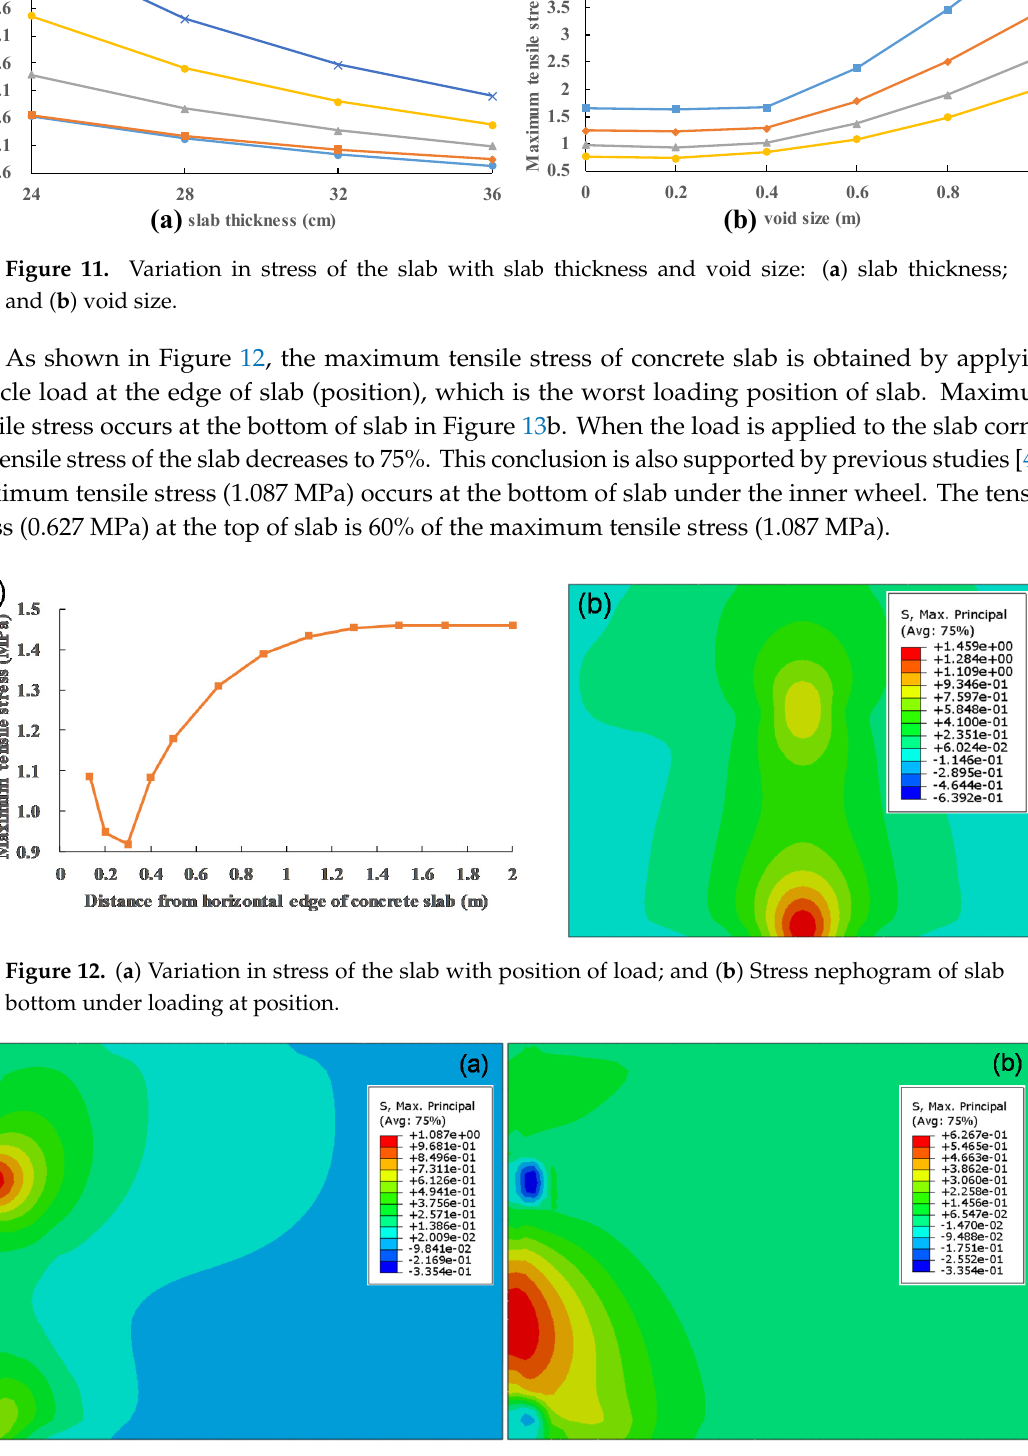
Figure 13. Stress nephogram of slab under loading at position 1: ( a ) the bottom of slab; and ( b ) the top of slab.